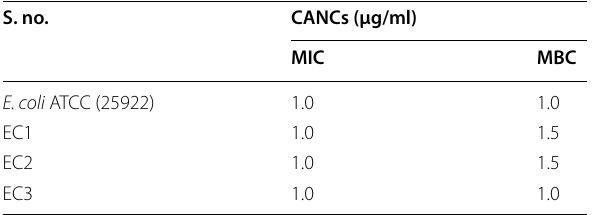
Table 3 Determination of minimum inhibitory concentration (MIC) and minimum bactericidal concentration (MBC) of the CANCs treated